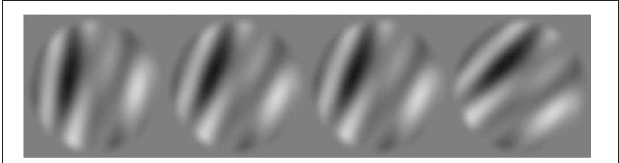
FIGURE 2 | First-order rotation stimulus. Stimulus is rotating clockwise. From this 4-frames sequence, it can be seen that a single noise frame is rotated in time. An example movie of these stimuli can be viewed in Lagacé-Nadon et al. (2009; Movie